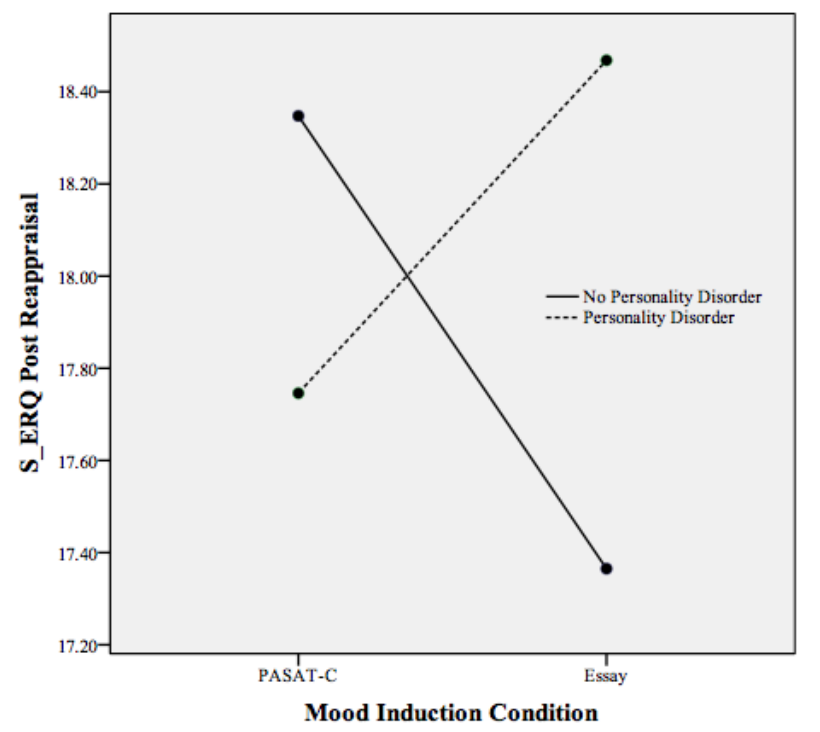
Figure 6. Plot of the non-statistically significant trends in the relationship between mood induction condition, personality disorder, and the reappraisal scale of the S-ERQ following both mood inductions. Higher scores indicate more use of reappraisal.